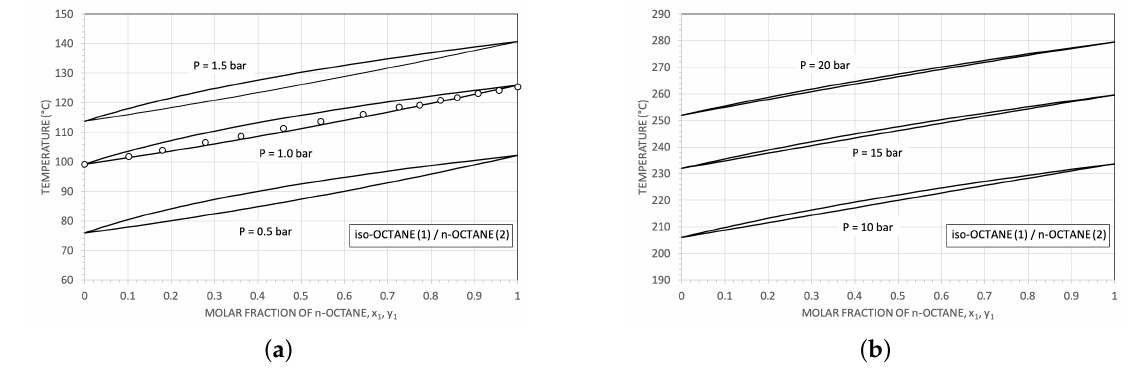
Figure 11. T − xy diagrams for the mixture i-C8 (0.5)/n-C8 (0.5) at different pressures. The white circles are from experimental literature data [44], and are reported as a comparison with the calculated values.